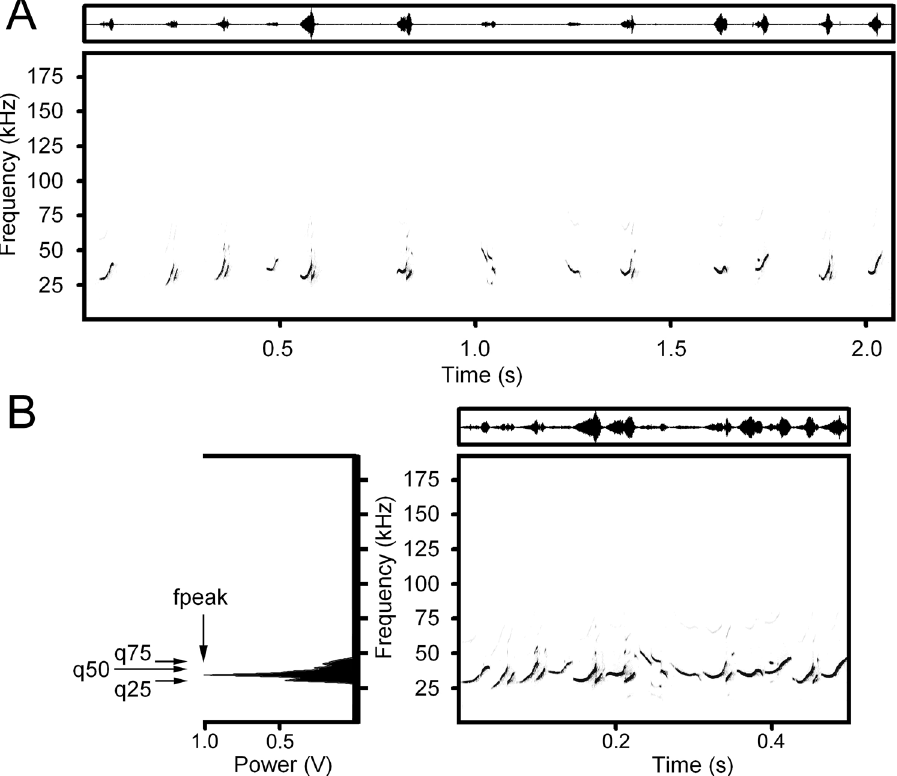
Figure 1. Procedure for preparation of a “joint call” and the maximum amplitude frequency and three power quartiles measure. ( A ) Spectrogram and wave-form of an intact natural sequence of USVs, separated with silent spaces, produced by adult female yellow steppe lemming. ( B ) Spectrogram, wave-form and power spectrum (left) of a part of the future joint call, made from the call sequence shown above. Measured acoustic variables: fpeak—the maximum amplitude frequency; q25—the lower quartile; q50—the medium quartile; q75—the upper quartile. Spectrogram was created using sampling frequency 192 kHz, Hamming window, FFT 1024 points, frame 50% and overlap